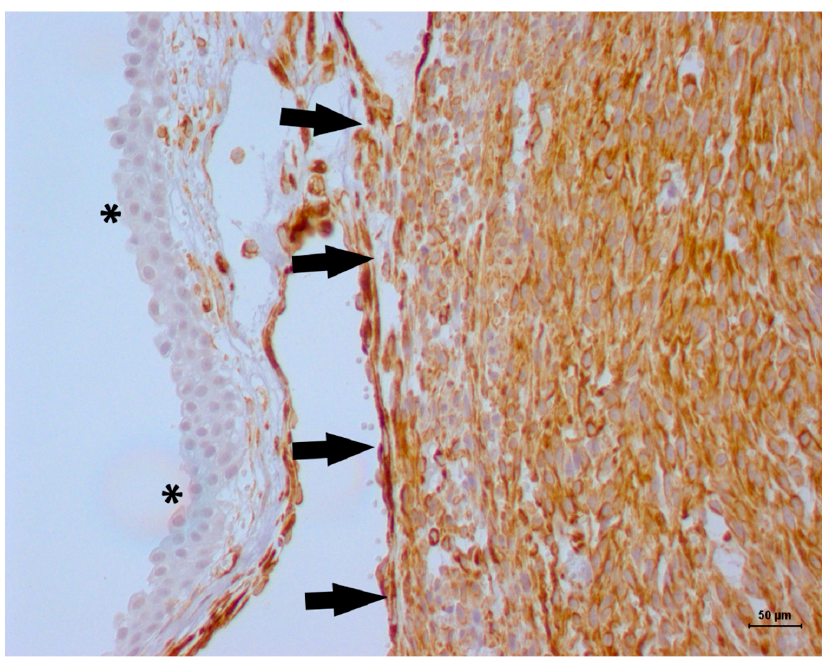
Figure 4. Feline bladder leiomyosarcoma. ( A ) Red staining in normal mucosa (urothelial epithelium, asterisk) and of tumor cells (black arrows) is shown, supporting the leiomyosarcoma diagnosis. The remaining collagen fibers are stained in blue (arrowhead). ( B ) Contrast between the blue staining of the collagen fibers (arrowhead) and the red staining of the tumor cells. Masson's trichrome stain, original magnification 20×.